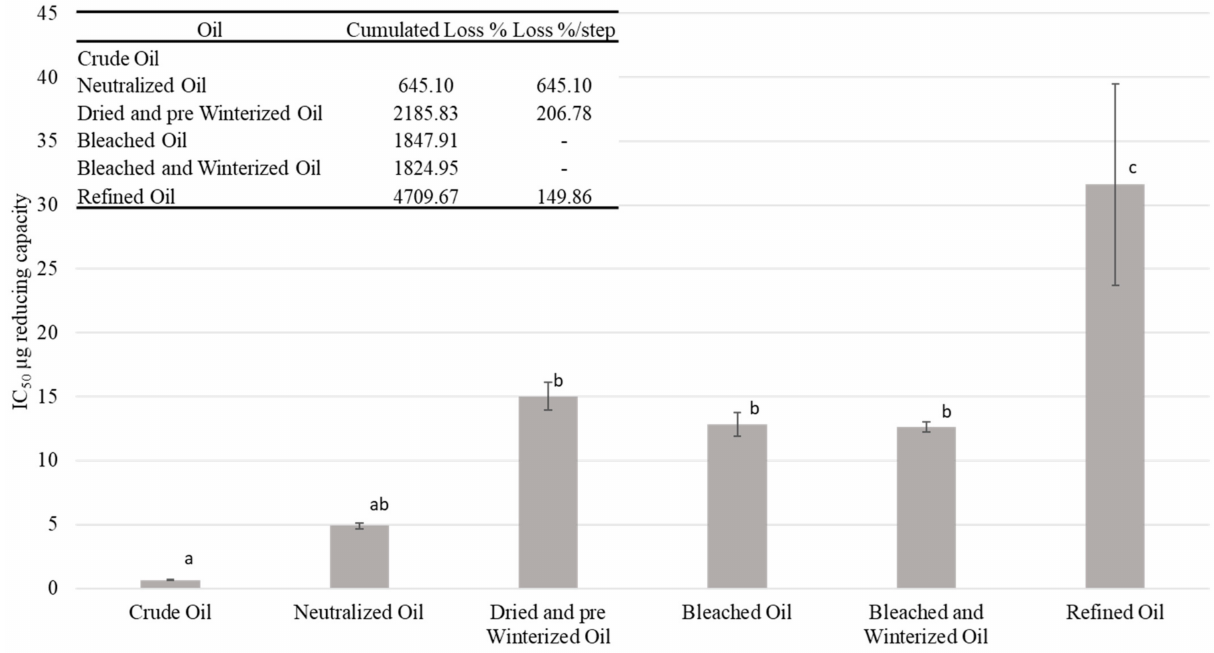
Figure 3. Evolution of the stability of the oil over the main steps of the refining process measured by the DPPH IC 50 , a–c different letters mean significant differences between steps p < 0.05 (Tukey’s